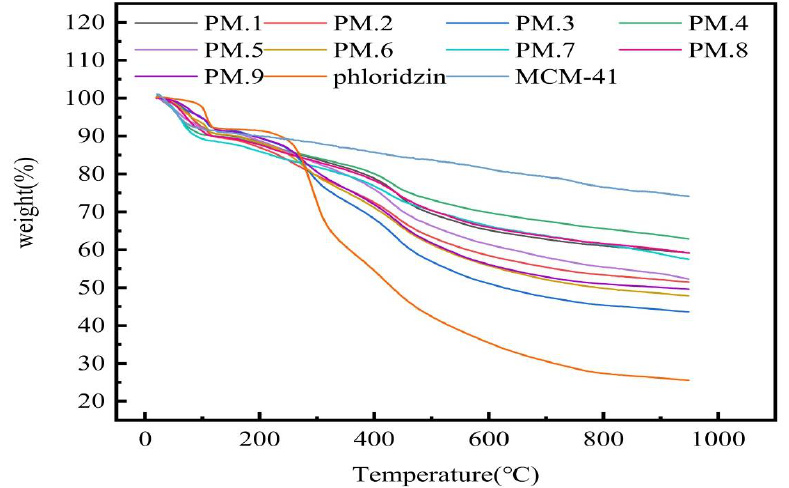
Figure 1. TGA curves of phloridzin/MCM-41 assemblies.